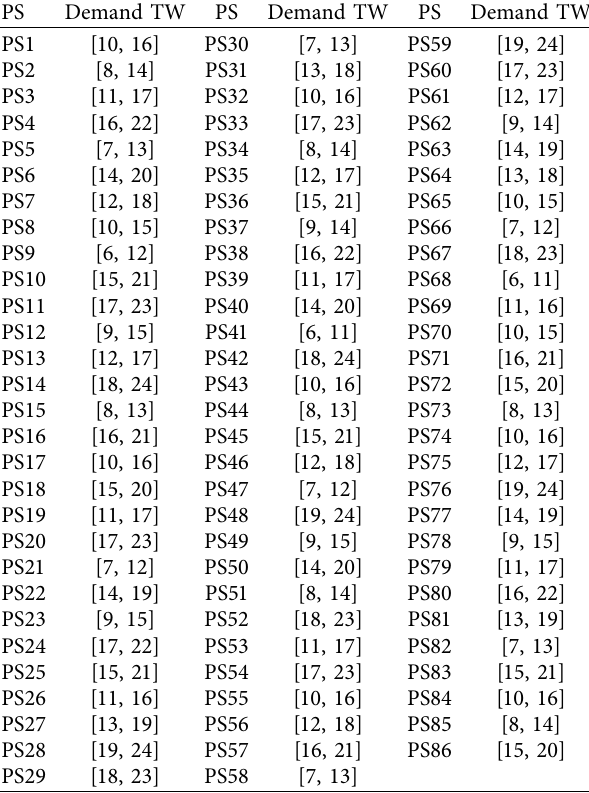
Table 6: TW demand of PS. Table 7: PS demand for different petrol types during a working